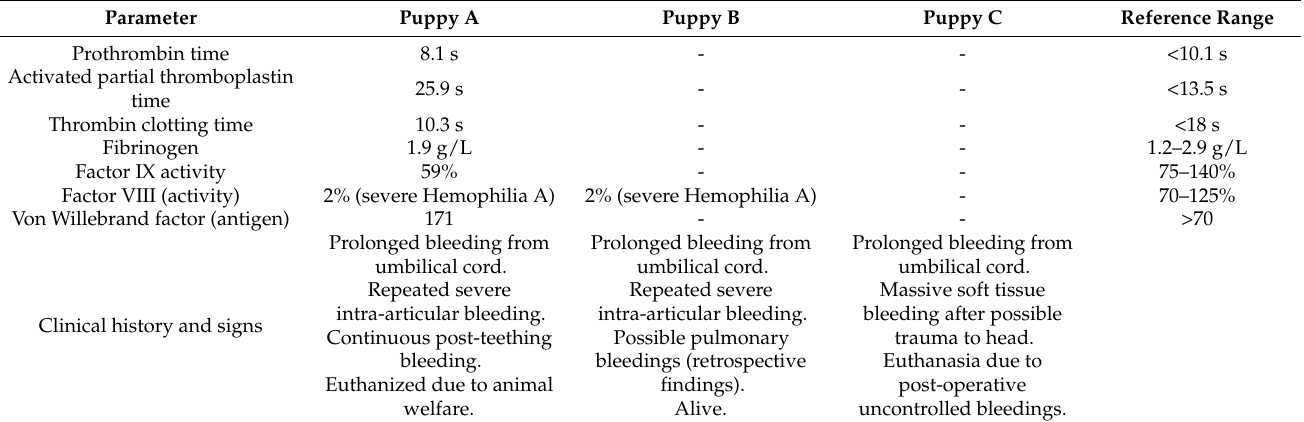
Table 1. Summary of clinical signs and clinicopathological parameters in affected dogs.